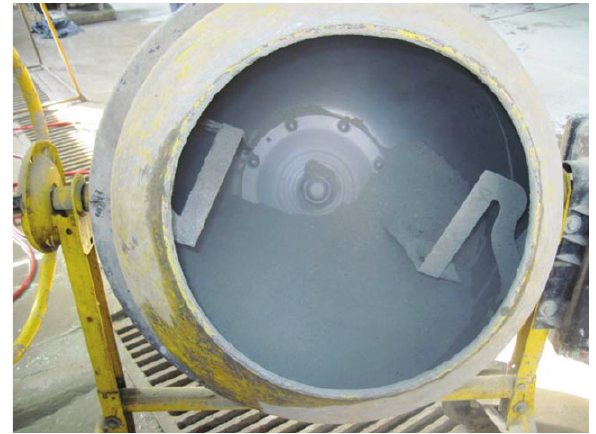
Figure 3 Dry mixing condition. water-containing VMA was added into the mixture and mixed for 1 min. Rheology of the fresh concrete was imme- diately determined after mixing to evaluate the workabil- ity of the